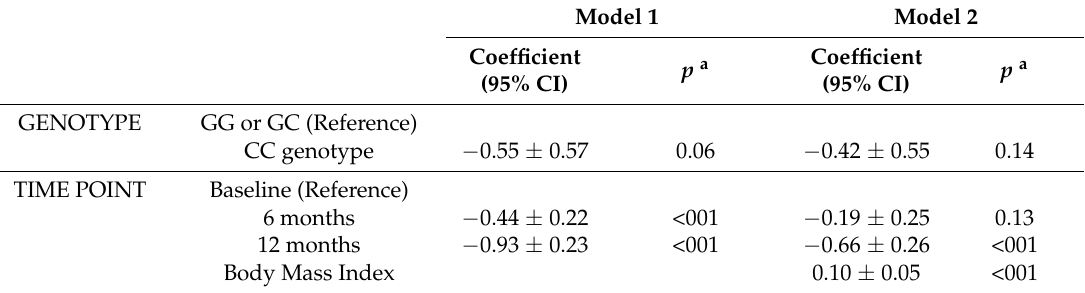
Table 2. Associations between IL-6 level and